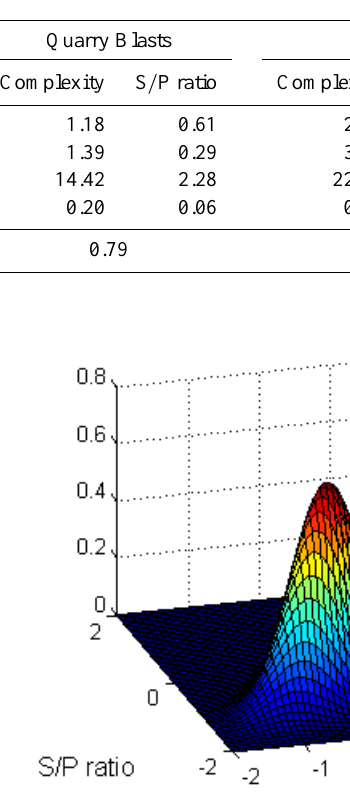
Fig. 3 Seismic events drawn from a two dimensional Gaussian lie into two clouds centered on the Fig. 3. Seismic events drawn from a two-dimensional Gaussian lie in two clouds centered on the means µ i . The method classifies the  . The method classifies the event in to two categories according to central distance. The ellipses means event into two categories according to central distance. The ellipses i show lines of equal probability density of the Gaussian. Values are show lines of equal probability density of the Gaussian. Values are in log scale. in log scale.